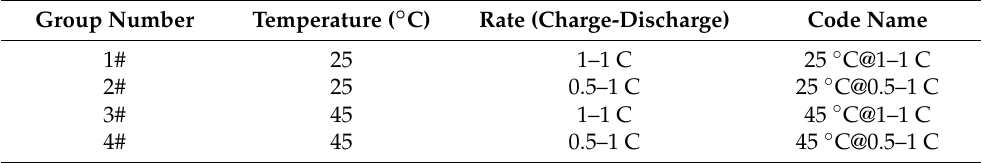
Table 2. Cycle life experimental matrix of NCA lithium-ion batteries under different conditions. Group